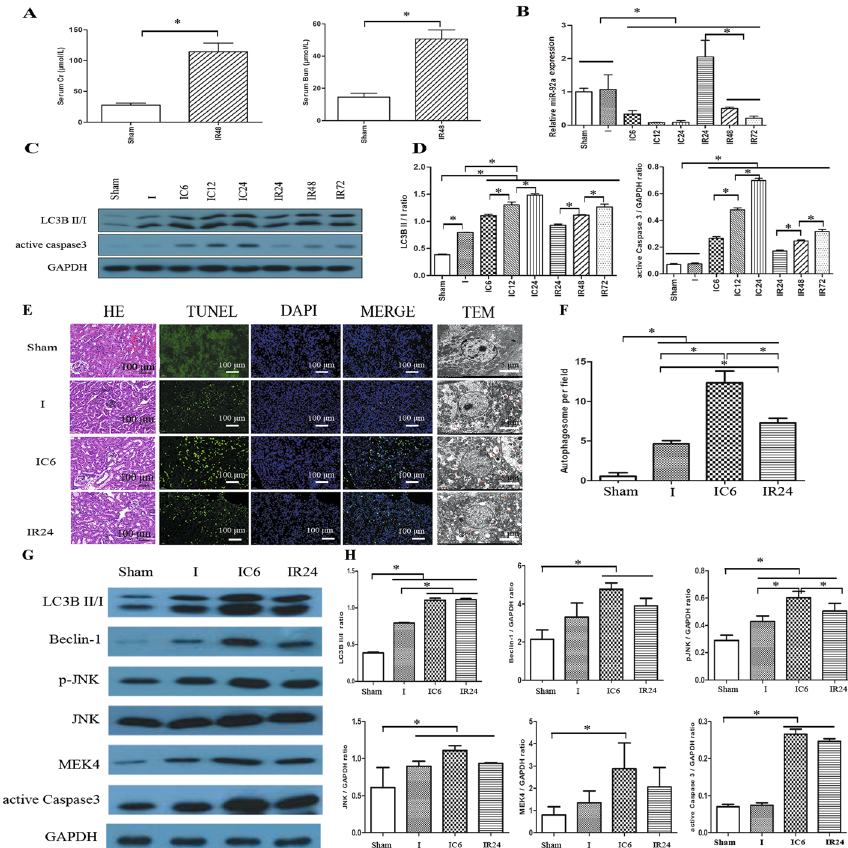
Fig. 1 IC and IR downregulated the expression of miR-92a and increased apoptosis and autophagy in mice. A The content of serum Cr and BUN in the sham and IR48 groups. B The expression of miR-92a. Representative band C and statistical analysis D of LC3B II/I and active caspase 3 expression using Western blotting. E Representative images of H&E staining ( 100), TUNEL ( 100), and TEM ( 2000) in each group. F The × × × statistical results of autophagosomes in I, IC, and IR groups. Using Western blotting, the representative band G and statistical analysis H of LC3B II/I, Beclin 1, pJNK, JNK, MEK4, and active caspase 3 expression. * P < 0.05. BUN blood urea nitrogen, Cr creatinine, GAPDH glyceraldehyde phosphate dehydrogenase, HE hematoxylin–eosin, I ischemia, IC ischemia and cold preservation, IRI ischemia and reperfusion injury, JNK c-Jun NH (2) terminal kinase, LC3B microtubule-associated protein 1 light chain 3B, MEK4 mitogen-activated protein kinase,